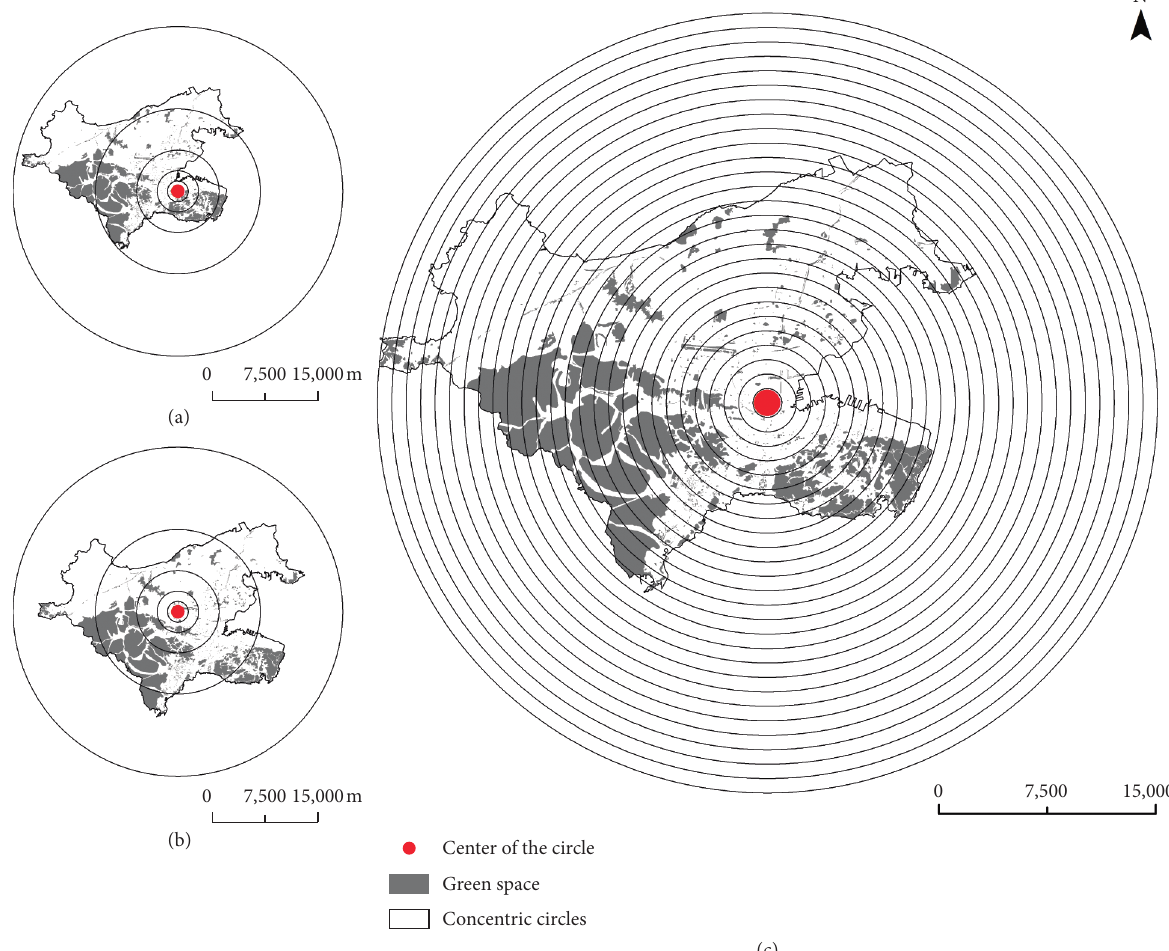
Figure 4: Three schemes for the center, radius, and scale analysis. (a) Taking the city administrative center as the center, the geometric scale of radius r � 60, 120, 240, ... , 61,440m, a total of 10 sets of data points. (b) With the center of gravity of the study area as the center of the circle, the geometric scale of radius r � 25, 50, 100, ... , 51,200 m, a total of 11 sets of data points. (c) Taking the center of urban green space (removing the woodland type) as the center of the circle, the radius r � 1000, 2000, 3000, .. . , 27,000, a total of 27 sets of data